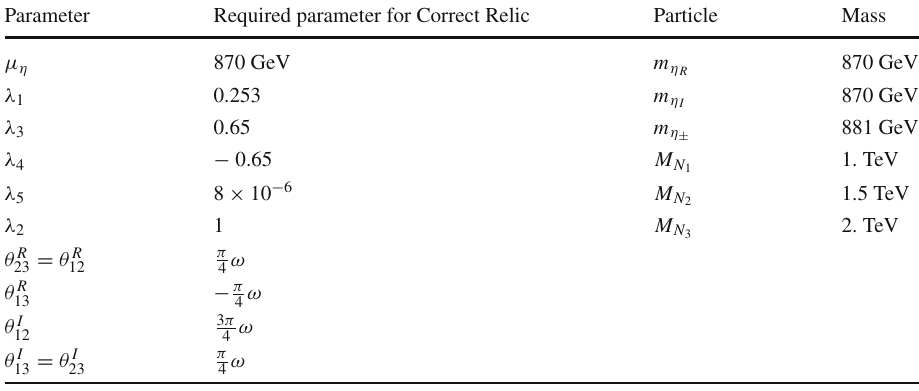
Table 2 The numerical values of light neutrino parameters used in the calculations